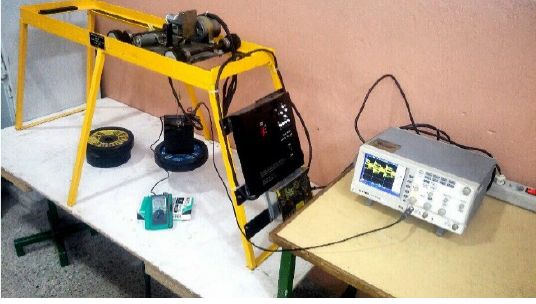
Figure 8: The fabricated magnetic crane